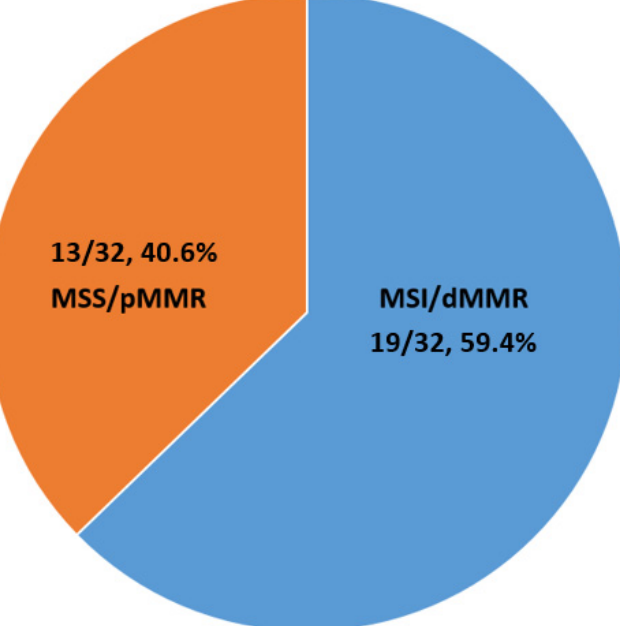
Figure 1. Summarizing figure highlighting the prevalence of MSI/dMMR in high-TMB PDAC. Abbreviations: MSI: microsatellite instability; dMMR: defective mismatch repair; MSS: microsatellite stable; pMMR: proficient mismatch repair.